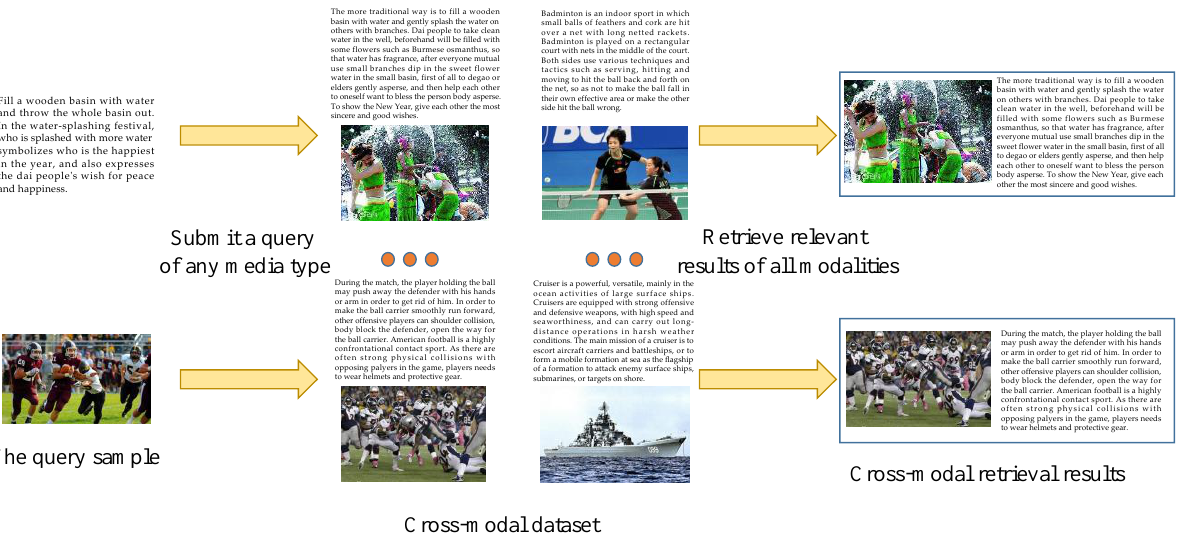
Figure 2. The cross-modal retrieval task includes image retrieving text and text retrieving image. In this paper, O = { o i } n i= 1 denotes the dataset containing n sample pairs and o i = ( I i ,T i ) represents the image–text pair. F iI is the image’s real-value feature vectors. Correspondingly, F iT is the real-value feature vectors of the text. We map F iI and F iT to the compact